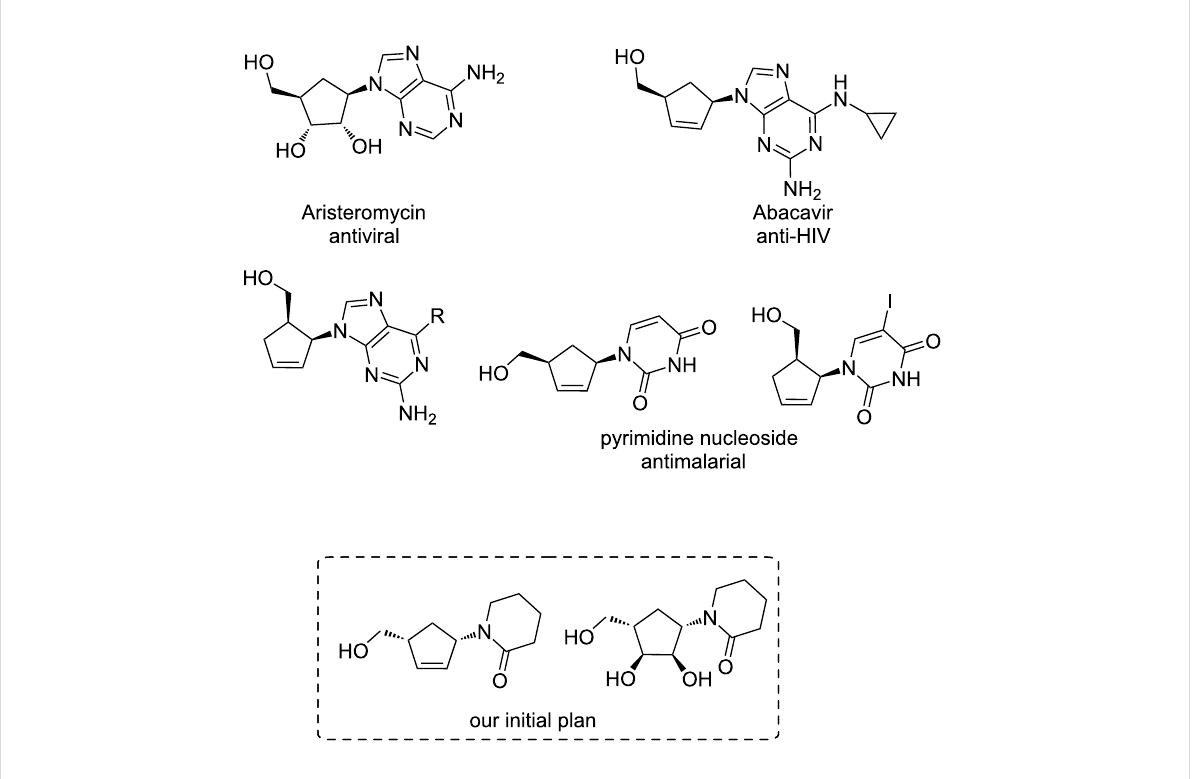
Figure 1: Selective carbocyclic nucleoside analogues from the literature and our initial